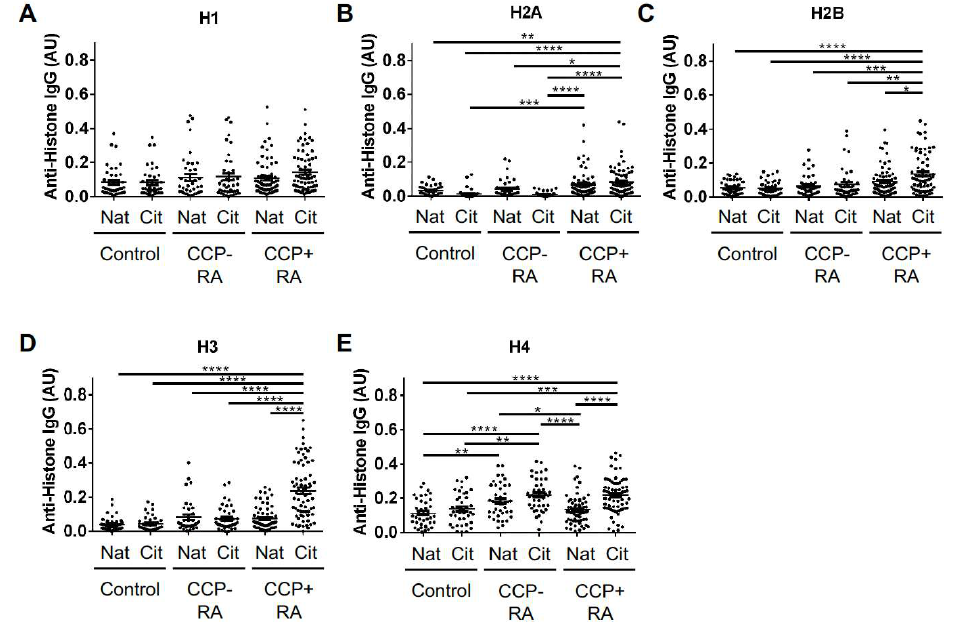
Figure 2. Anti-histone IgG levels in control and rheumatoid arthritis subjects. IgG levels against native (Nat) and citrullinated (Cit) histone H1 ( A ), histone H2A ( B ), histone H2B ( C ), histone H3 ( D ), and histone H4 ( E ) were measured by ELISA for controls, CCP − rheumatoid arthritis (RA) and CCP + RA. Graphs depict average absorbance values in arbitrary units (AU) with SEM. Groups were compared by ANOVA. For all graphs, n = 39 controls, 41 CCP − RA, 70 CCP + RA; * p < 0.05, ** p < 0.01, *** p < 0.001, **** p <